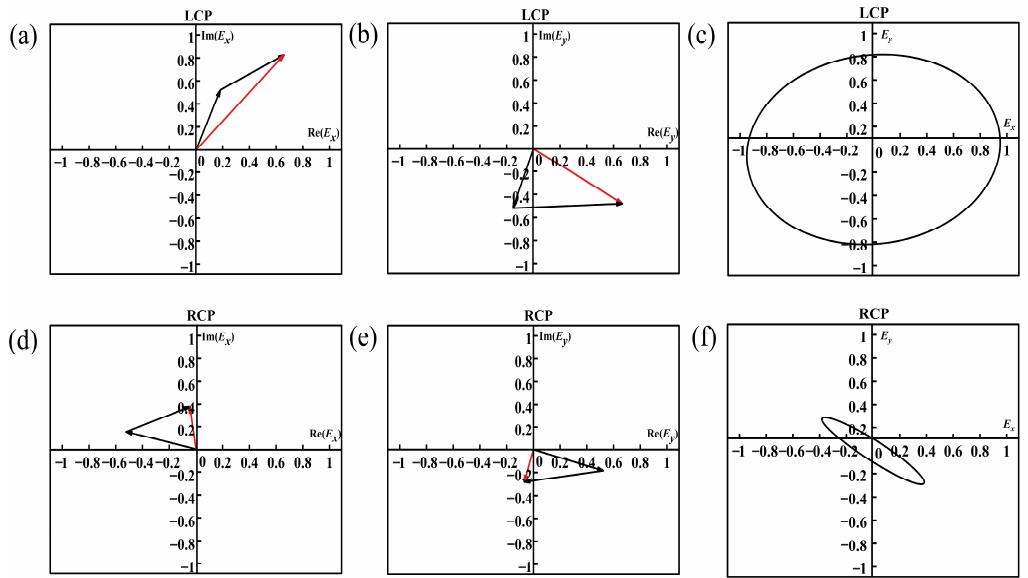
Figure 6. Simulation of design ideas. ( a , b ) The two black vectors represent the left-handed circularly polarized light passing through the double orthogonal rectangular slots array and the spatially π /4 tilted arrangement of the rectangular slot array, and their respective components of the emitted light in the x and y directions; the red vectors represent their sum vectors. ( c ) The Ey and Ex at different times (under the left-handed circularly polarized light) ( d , e ) The two black vectors represent the right-handed circularly polarized light passing through the double orthogonal rectangular slots array and the spatially π /4 tilted arrangement of the rectangular slot array, and their respective components of the emitted light in the x and y directions; the red vectors represent their sum vectors. ( f ) The Ey and Ex at different times (under the right-handed circularly polarized